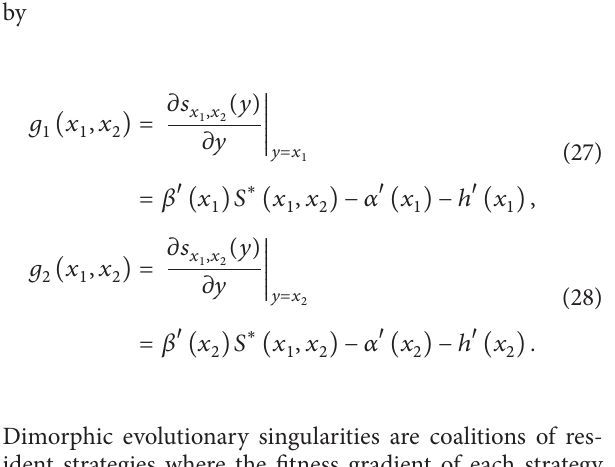
𝑥 1 and the other with strain